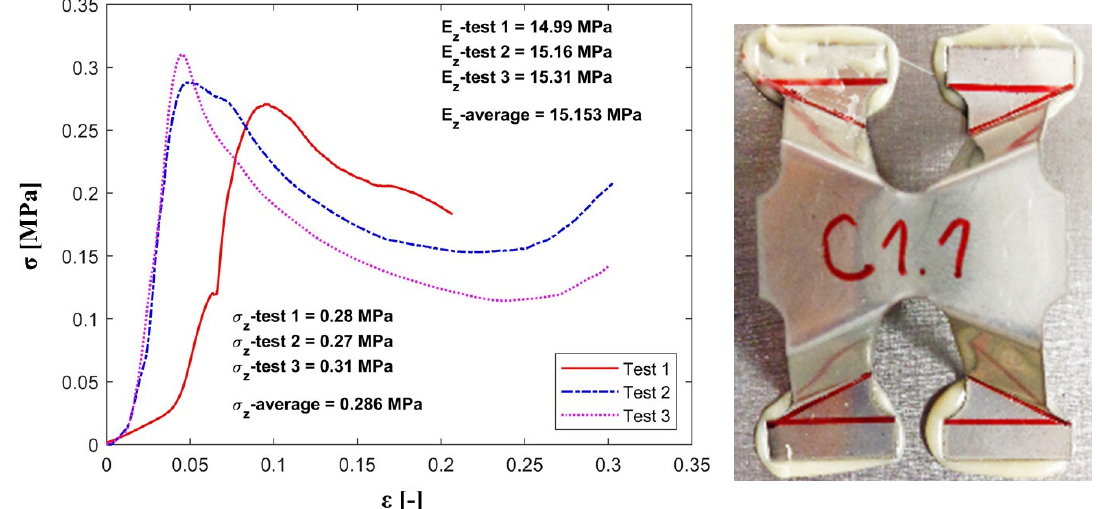
Figure 6. Stress-strain plot for the C1 configuration under out-of-plane compression.